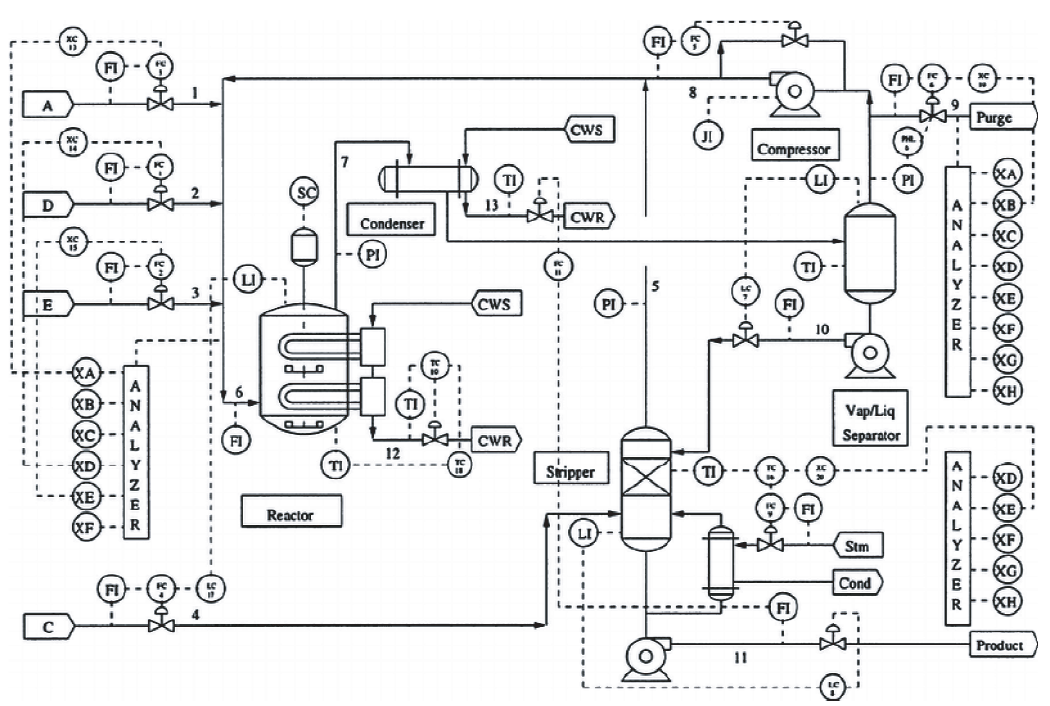
Figure 12: Tennessee Eastman Process [75].